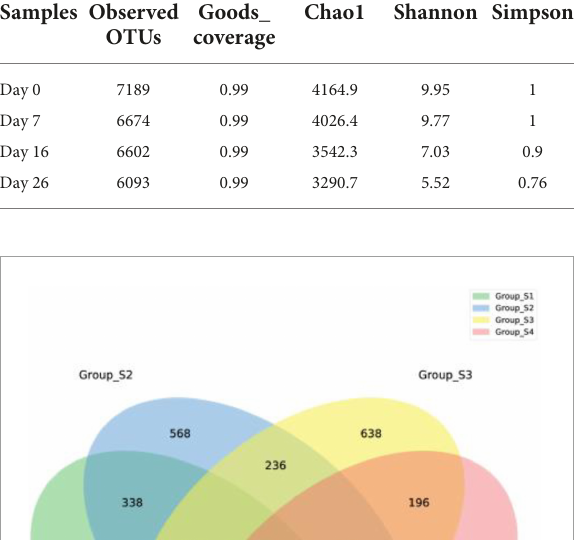
FIGURE3 A Venn diagram of fermented mutton sausage during natural ripening based on the OTUs of bacteria.